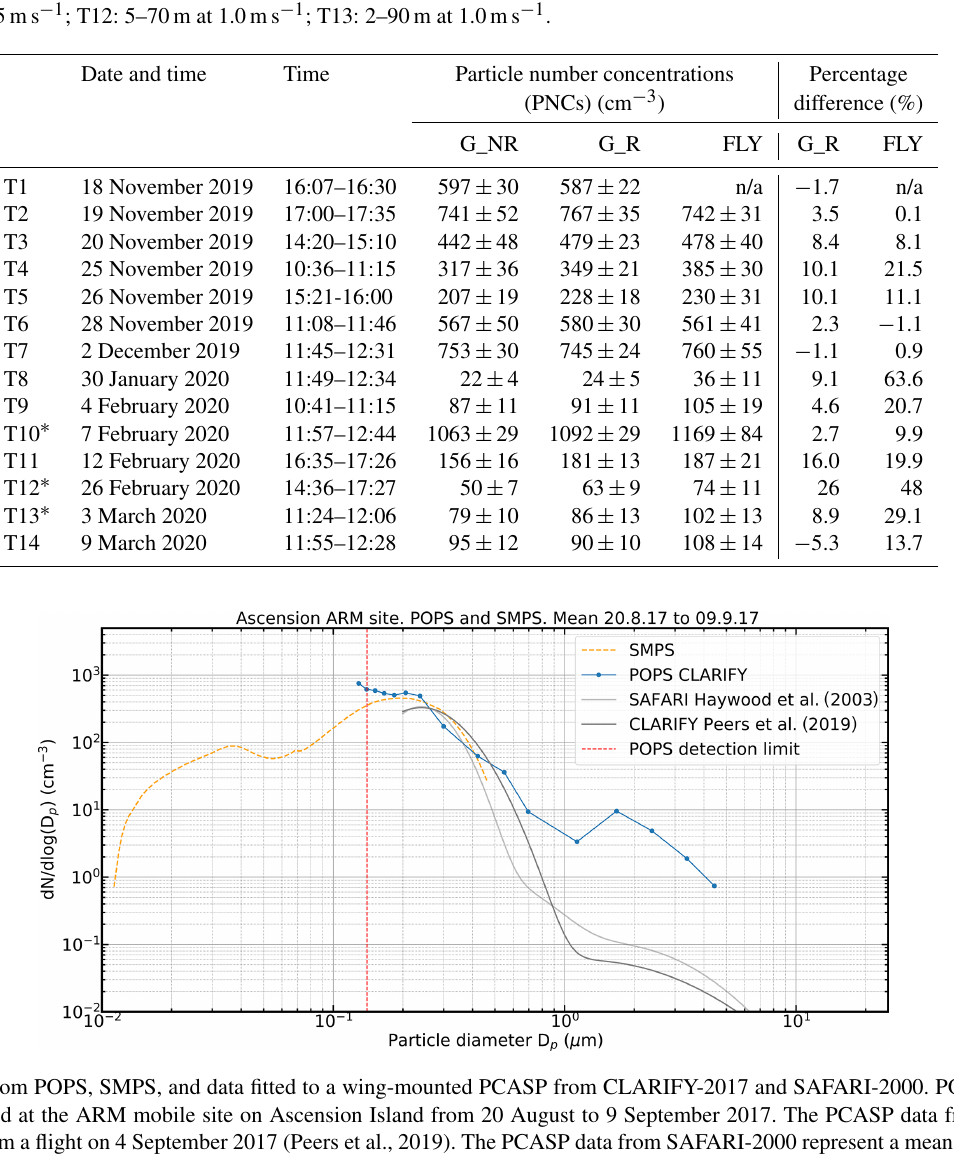
Table 1. Summary of the PNCs of each test flight at three stages. n/a = not applicable. The numbers denoted by ± x represent the standard deviation in the PNCs during the measurement time period. An asterisk ( ∗ ) indicates that profiles were also performed as documented here.